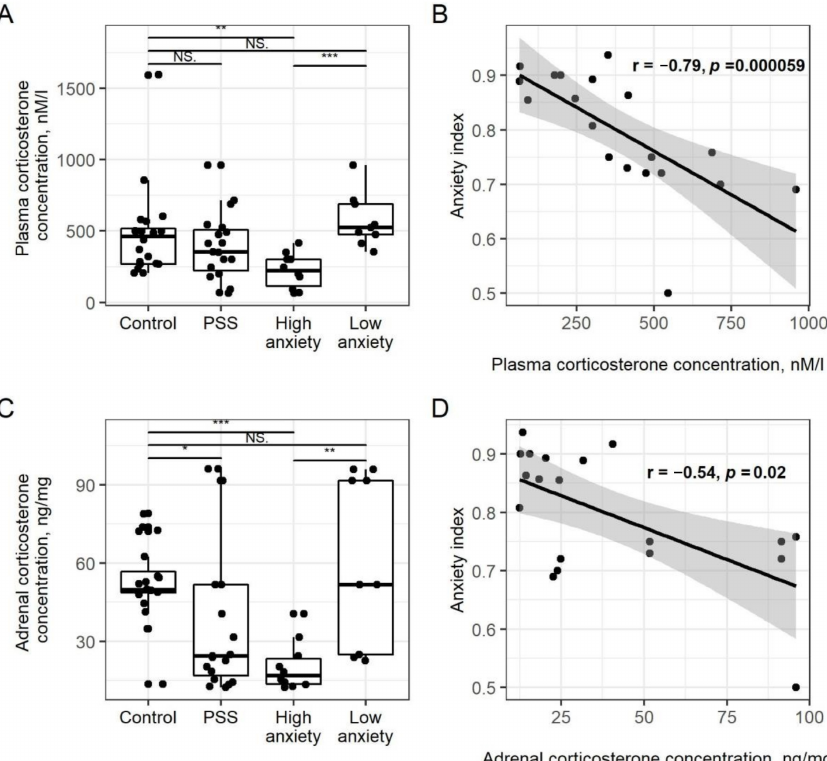
Figure 1. PSS causes a decrease in corticosterone . Panel ( A ). Plasma CORT concentrations in PSS rats segregated into high- and low-anxiety groups according to AI as determined by performance in the EPM. Differences in plasma CORT concentrations among groups are shown as boxplots with dots representing individual data values and medians shown by horizontal lines. The boxes include the central 50% of the data, i.e., from the 25th to the 75th percentile. The whiskers include the data contained within 1.5 times the interquartile range. NS = p > 0.05; * p < 0.05; ** p < 0.01; *** p < 0.001. p values determined in non-parametric analysis. Panel ( B ). Spearman correlation between AI values and plasma CORT concentrations in PSS rats. Gray area around the line represents the 95% confidence interval. Panel ( C ). Adrenal CORT concentrations. See Panel A legend for detailed description of the plot. Panel ( D ). Spearman correlation between AI and adrenal CORT concentrations in PS rats. Gray area around the line represents the 95% confidence